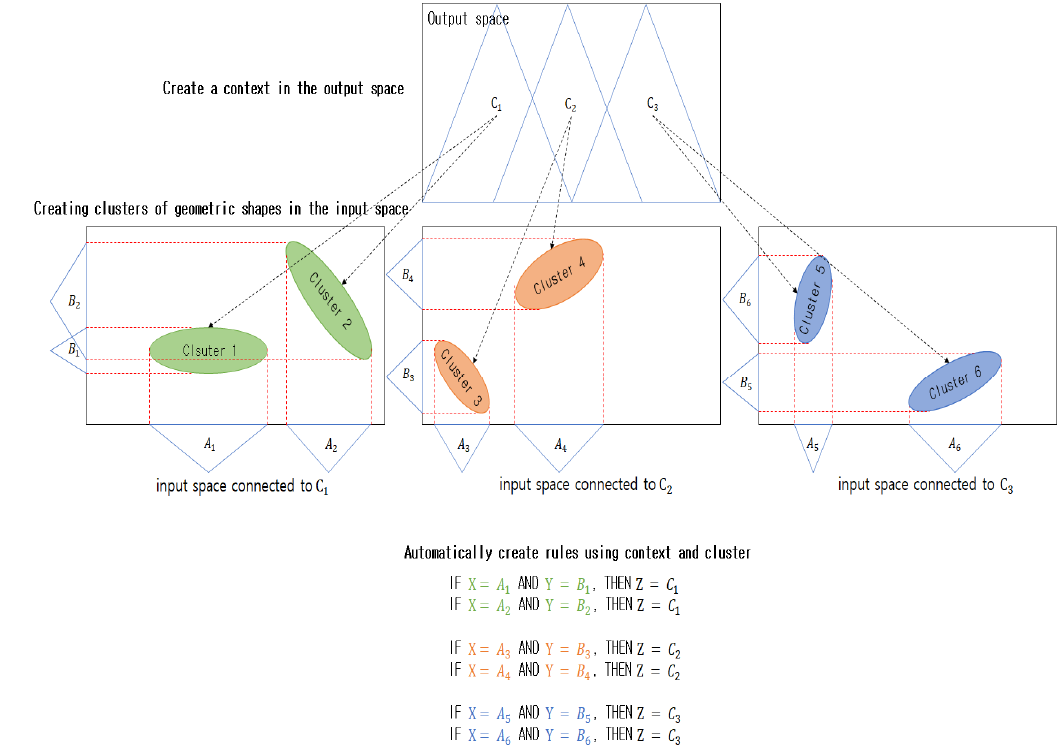
Figure 1. Concept of context-based GK clustering.